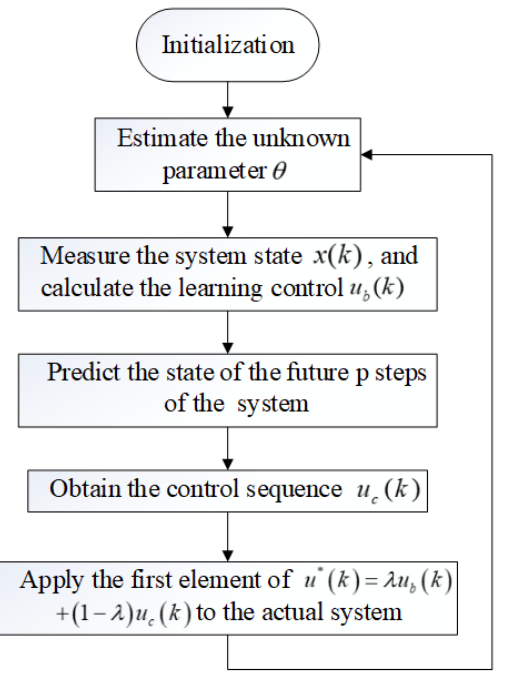
Figure 2. Flow diagram of the algorithm. 1. Initialize at time k = 0 given the predictive horizon ( p ) and the stopping time N ; 2. 3. Measure the system state x ( k ) , and use (23) to calculate the learning control u b ( k )